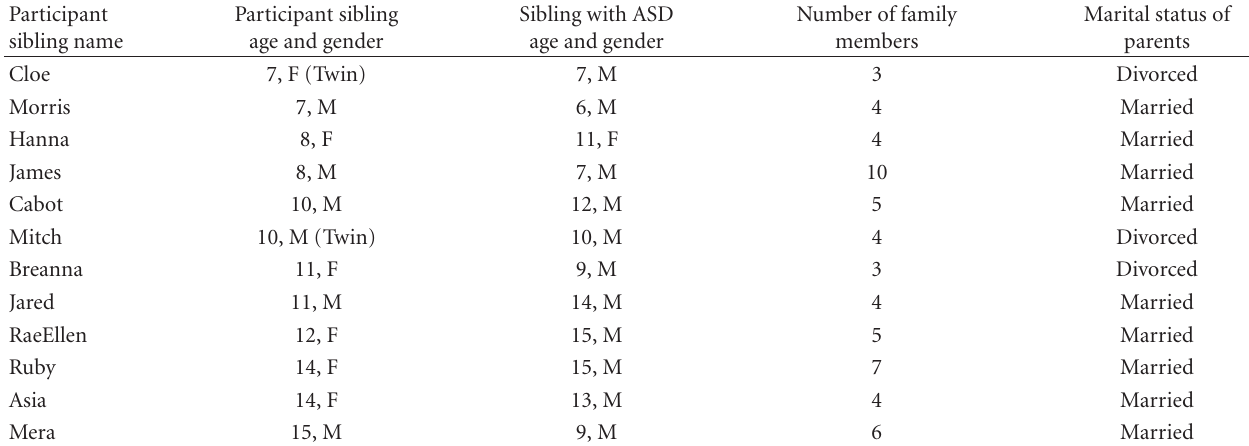
Table 1: Participants’ demographic